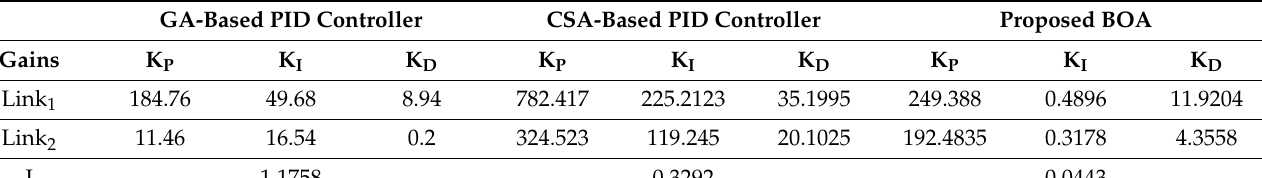
Table 1. The controller gains of each technique and the corresponding value of the objective function (J).